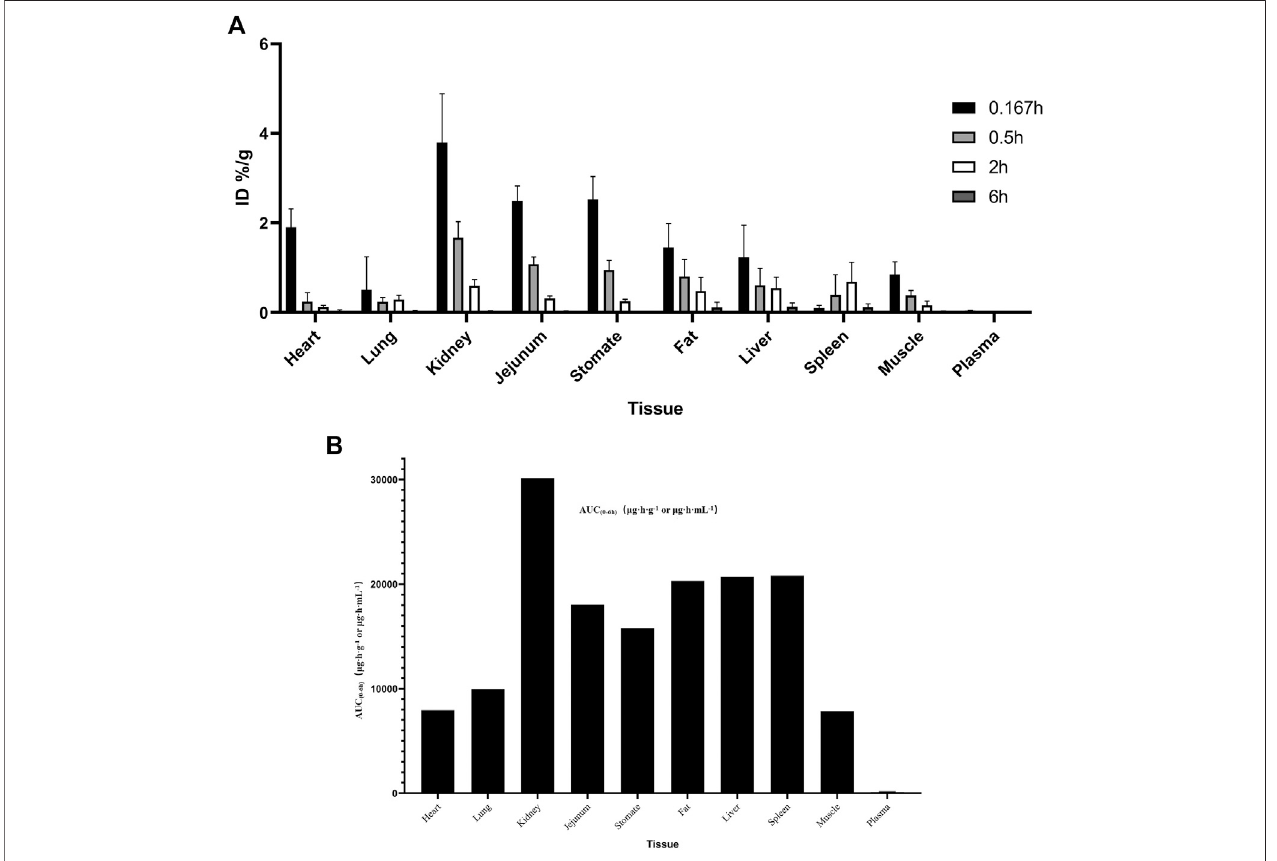
FIGURE2| Tissuedistribution ofMK-ASODN nanoliposomes following intravenous administration at adose of25 mg · kg − 1 torats( n (cid:1) 5). (A) ID%/g oftissues, (B) AUC of tissues.